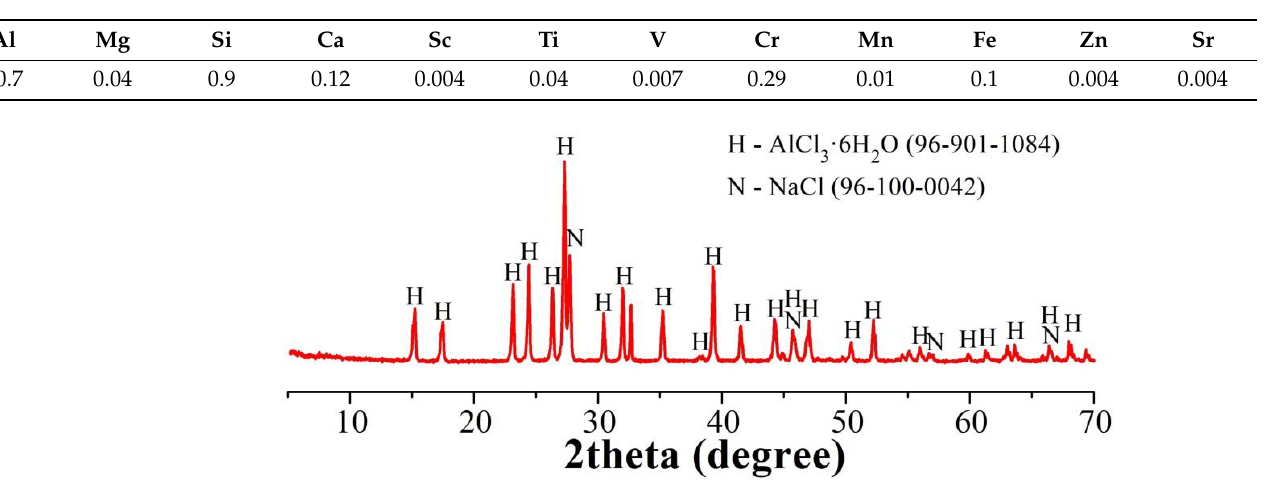
Figure 7. TG-DTA plots of ACH precipitated from the mother liquor. The first endo-effect at 207 °C with the major mass loss is clearly related to the de- composition of ACH to form amorphous Al 2 O 3 [55]. The exothermic peak at 736 °C is re- sponsible for the transition from amorphous Al 2 O 3 to γ -Al 2 O 3 [56]. The endothermic peak at 798 °C is apparently the melting point of NaCl [57]. Based on the results of TG-DTA analysis, we chose the temperature of ACH calcination as 800 °C to obtain γ -Al 2 O 3 . Figure 8 demonstrates the XRD patterns of Al 2 O 3 prepared by calcination of the pre- cipitated ACH, as well as by calcination of the precipitated ACH, water washing to re- move sodium chloride, and repeated calcination. The patterns indicate that the calcined sample contains NaCl and γ -Al 2 O 3 (Figure 8a). SEM confirmed the presence of crystalline AlCl 3 ·6H 2 O and NaCl in the precipitated ACH sample (Figure A1). The crystal morphol- ogy is also inherited from the ACH sample after its calcination at 800 °C (Figure A2, Table